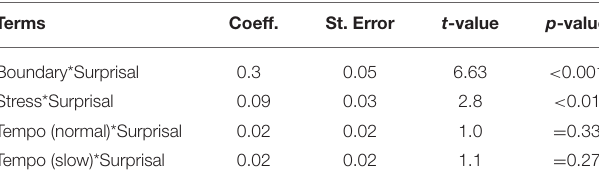
TABLE 8 | Interaction model of vowel dispersion: interaction of surprisal with prosodic